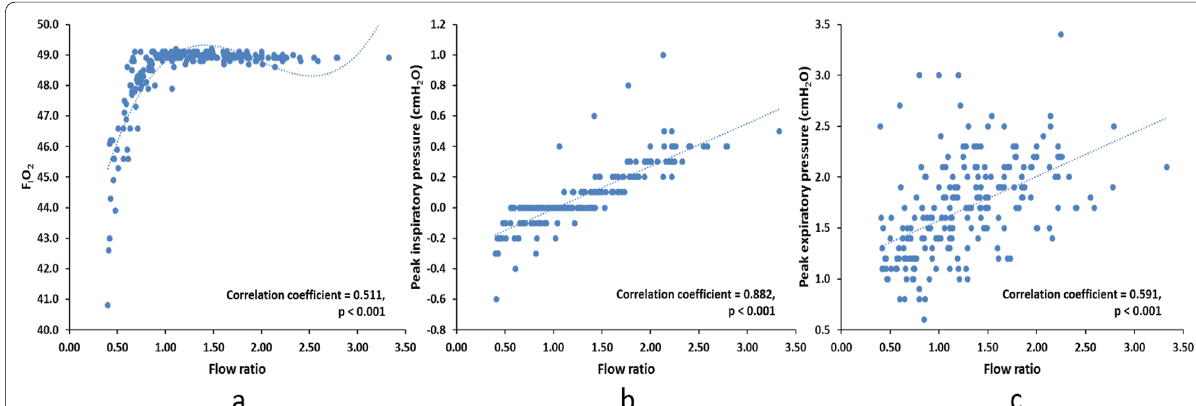
Fig. 3 The correlation between flow ratio and F I O 2 , peak inspiratory and expiratory pressure at trachea in the in vitro study. X-axis is the flow ratio of setting HFNC flow to peak tidal inspiratory flow, Y-axis is the trachea F I O 2 (left), peak inspiratory (middle) and peak expiratory pressure (right). As the flow ratio increased, both peak inspiratory and expiratory pressure increased, while F I O 2 stabilized when flow ratio was